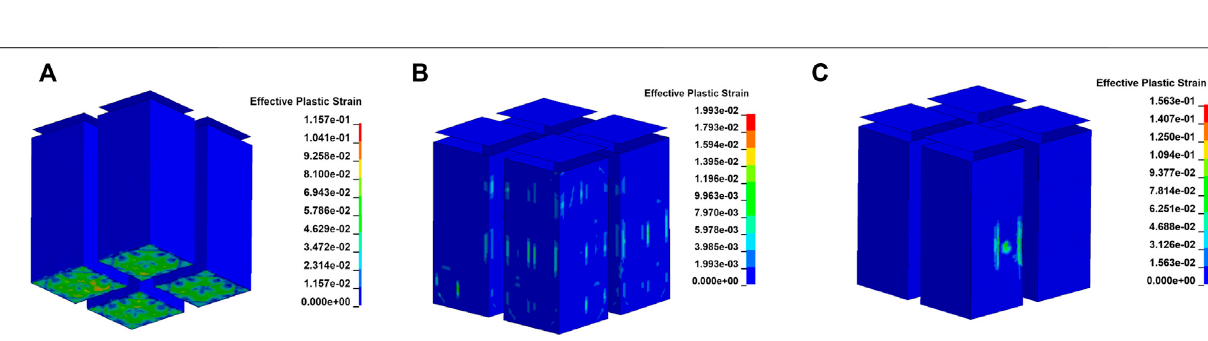
FIGURE11| Effectiveplasticstraincontoursofthelids,sidewalls, andbottomwallsofcanister (A) under9-mbottom-downdrop (B) 9-mtop-corner drop (C) 1 m side puncture.